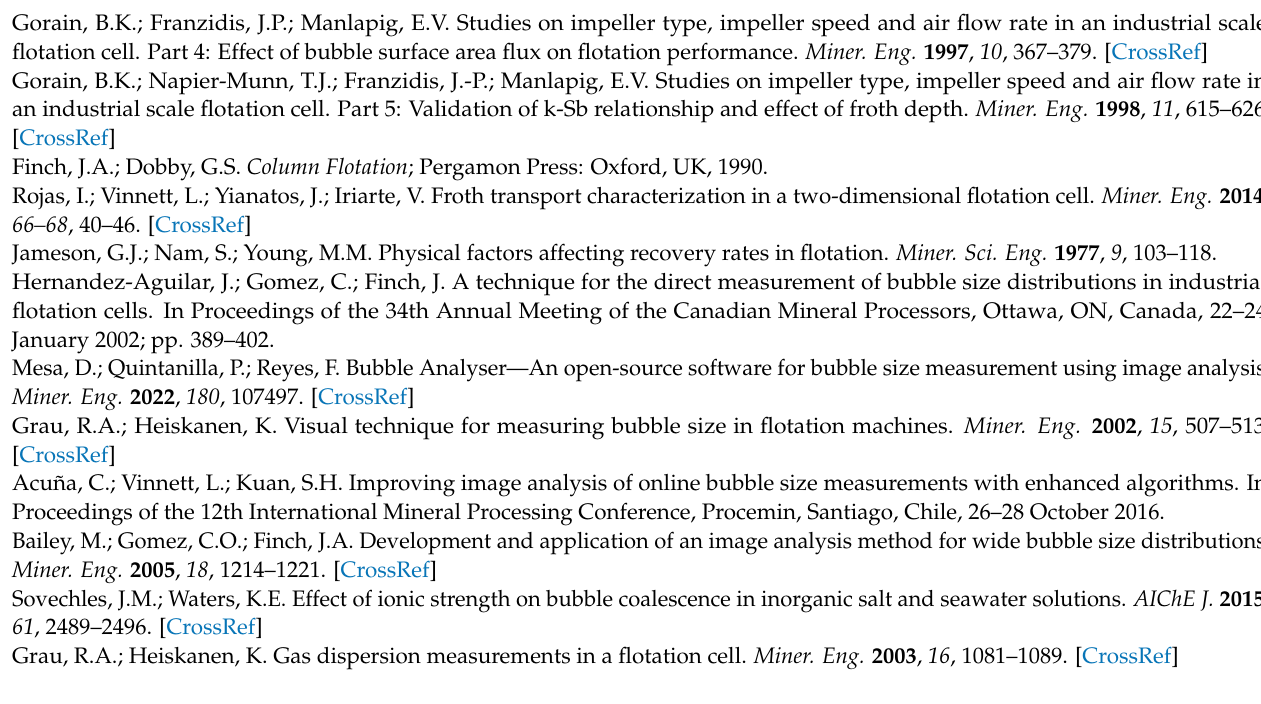
Figure A2. Examples of bubbles under abnormal gas dispersion conditions. Scales in millimeters and centimeters.